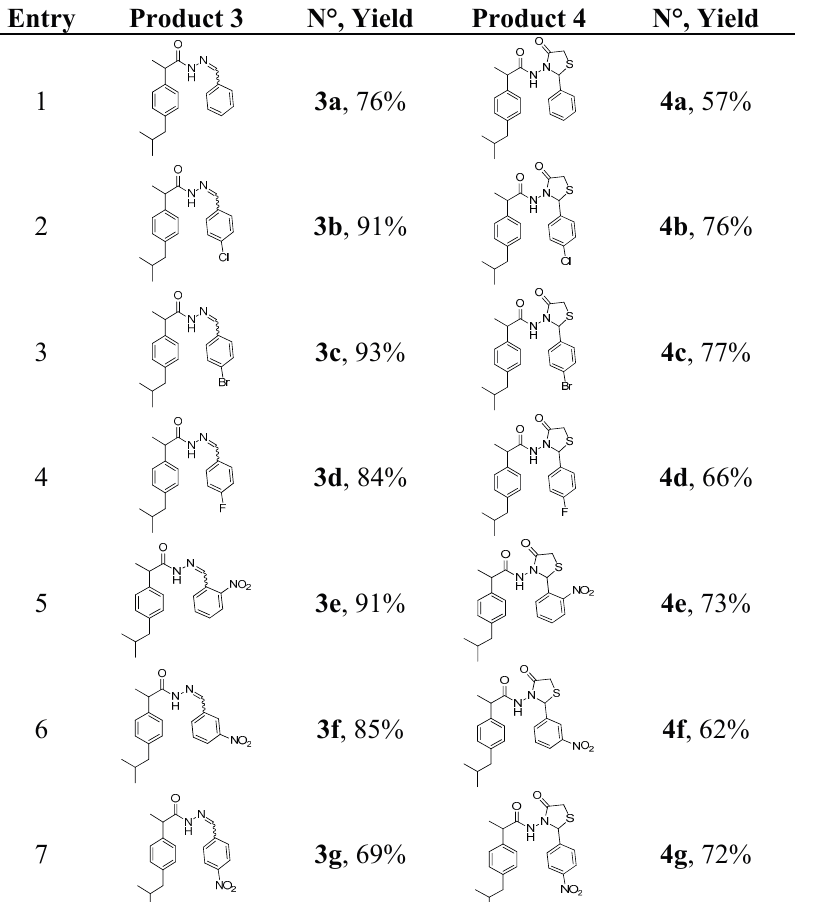
Table 1. Synthesized derivatives 3 and 4